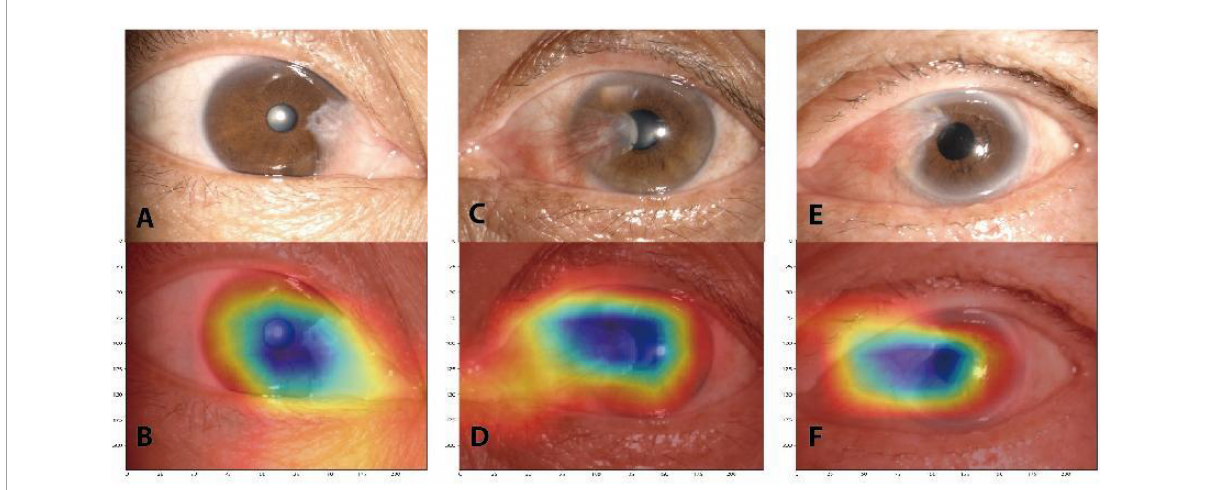
FIGURE5 Gradient-weighted class activation mapping (Grad-CAM) heatmaps that highlight important regions for the deep learning model predicted for pterygium classification. The original anterior segment images (A,C,E) . The corresponding heatmaps (B,D,F)